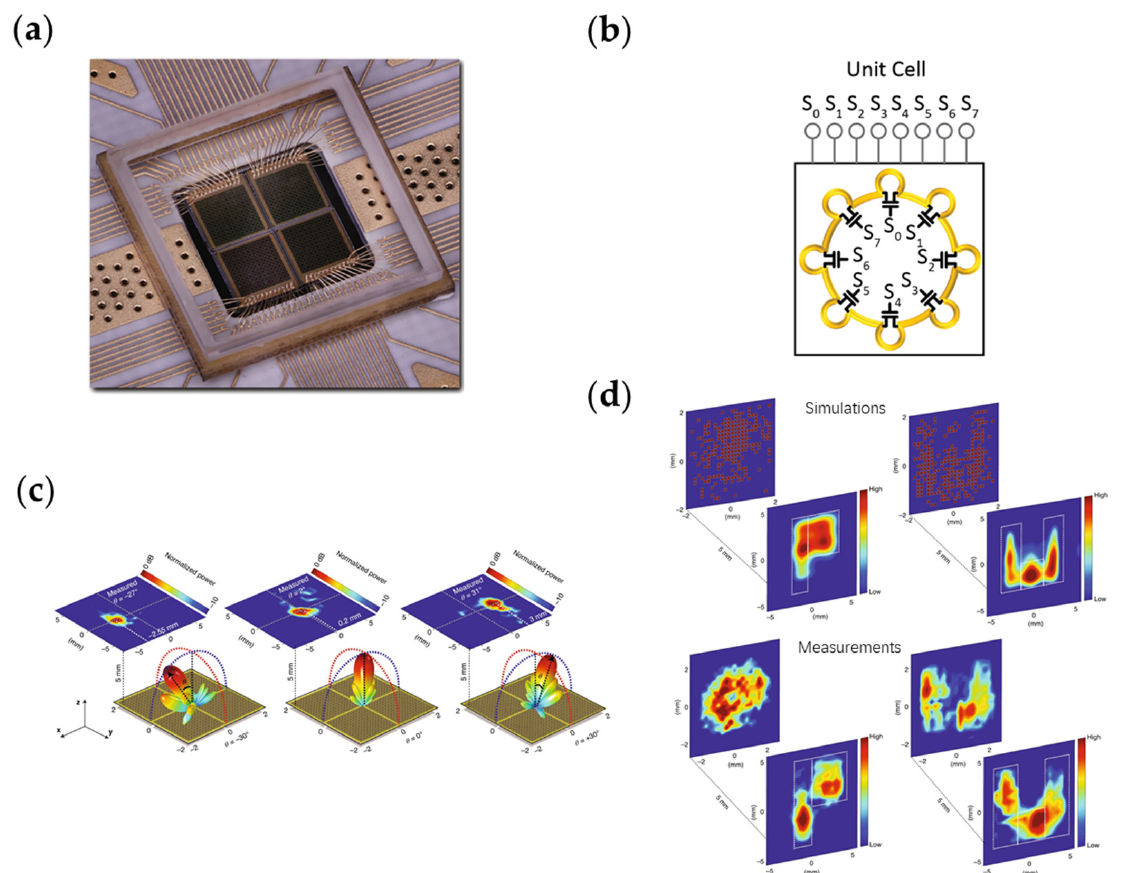
Figure 14. ( a ) A photo of the fabricated CMOS metasurface; ( b ) Schematic of a unit cell from the CMOS metasurface; ( c ) The performance of the metasurface to realize beam focusing; ( d ) The performance of the metasurface to realize holography. Reprinted with permission from [260], copyright 2023 Springer Nature.